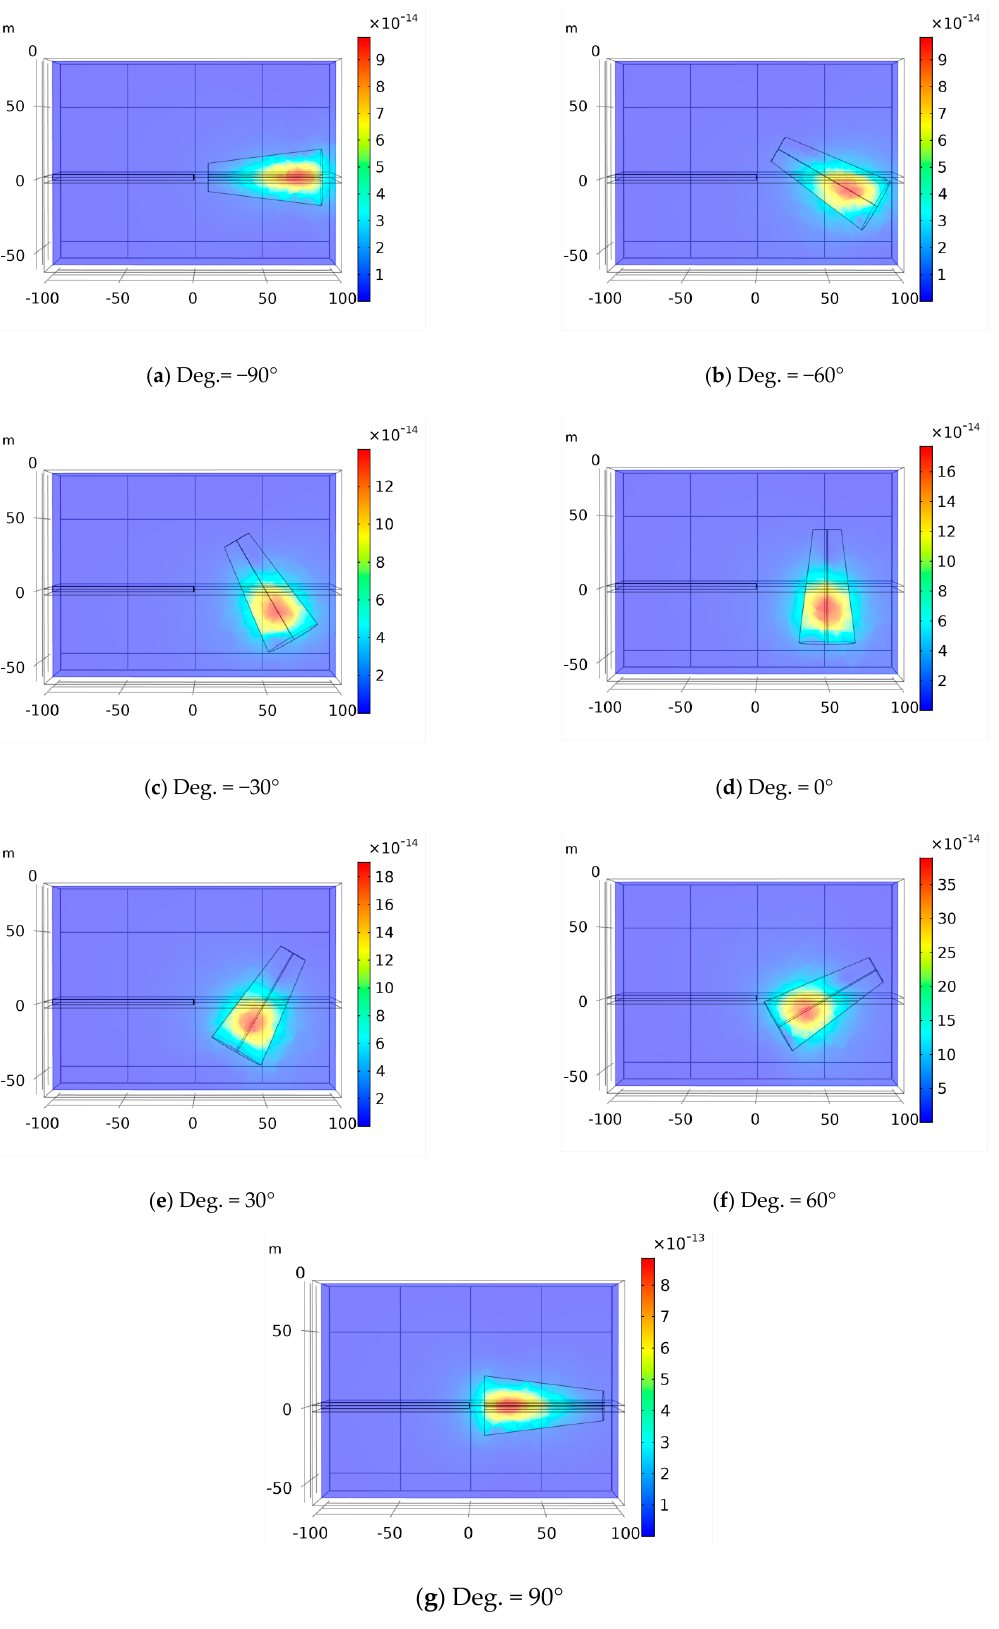
Figure 9. Transient electromagnetic response of 500 μ s after the shut ‐ off of different dip angle anom ‐ alies.